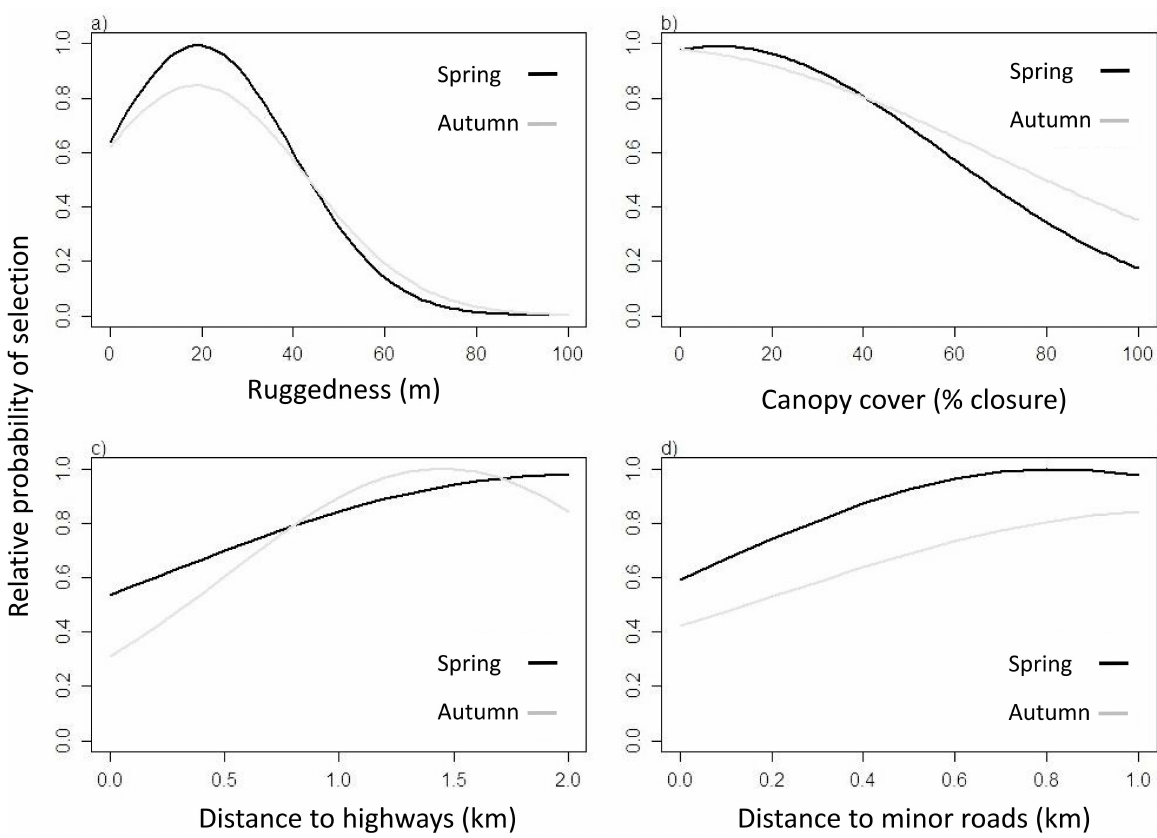
Fig 3. Relative probabilityof selectionestimated by Step Selection Functions (SSFs) during spring and autumn movements for a) terrain ruggedness, b) canopy cover, c) distance to highways and d) distance to minor roads.